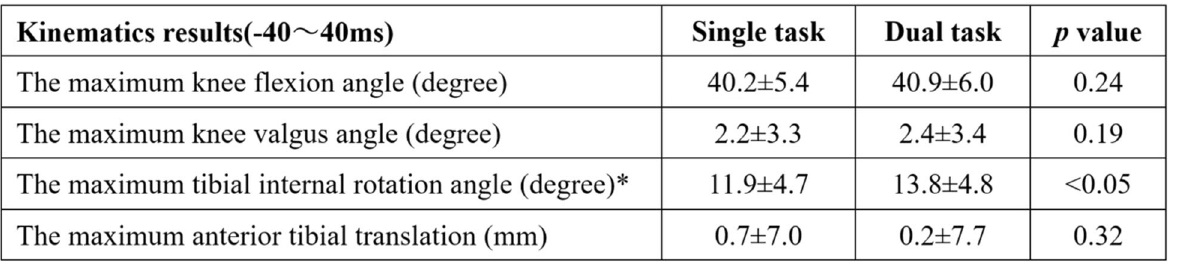
Table 1 Kinematics results comparing the single and dual task. Values are given as mean ±